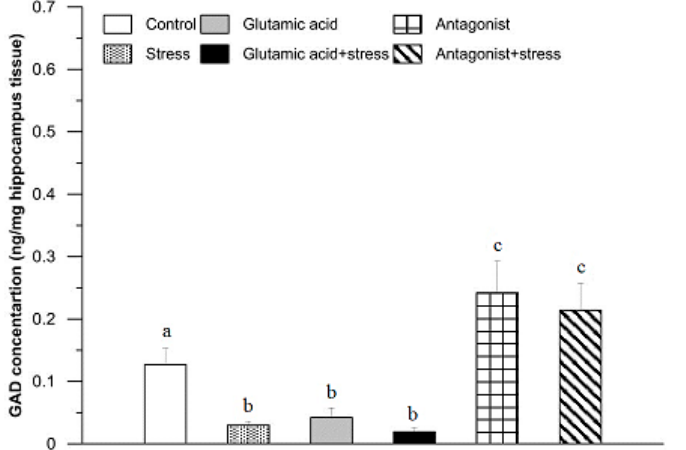
Figure 3. The effect of glutamic acid, stress, and glutamic acid receptor antagonist and their combinations with stress on the concentration of glutamic acid decarboxylase in the rabbit hippocampus. For further explanations, see Figure 1.